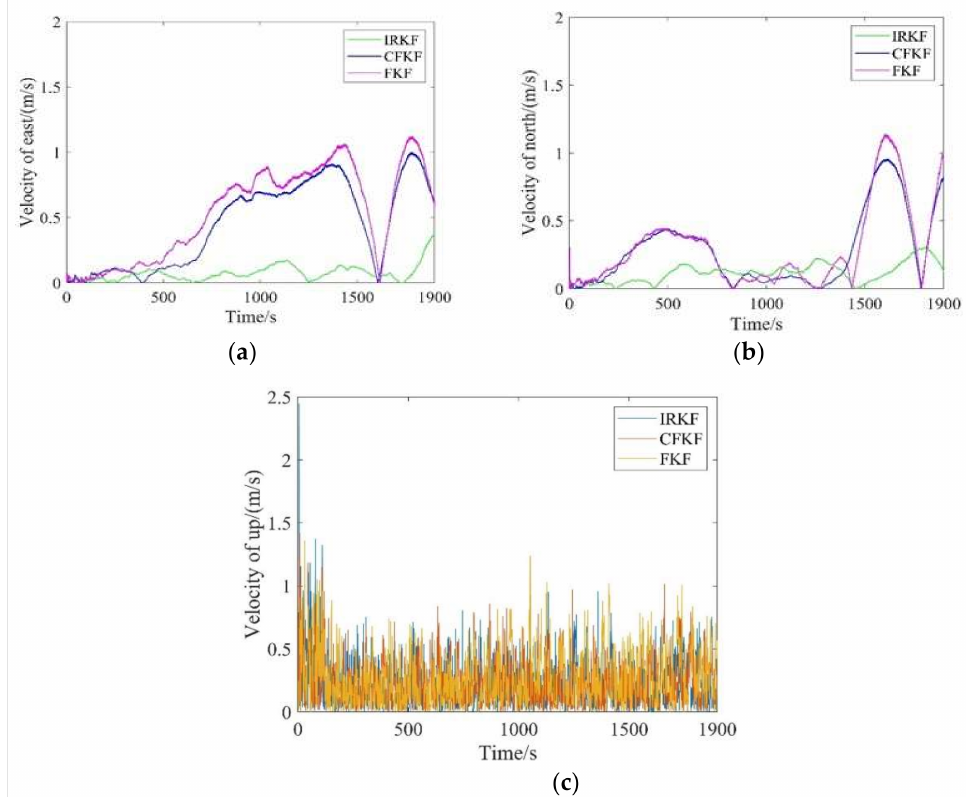
Figure 11. Estimation error of velocity. ( a ) Estimation error of east velocity. ( b ) Estimation error of north velocity. ( c ) Estimation error of north